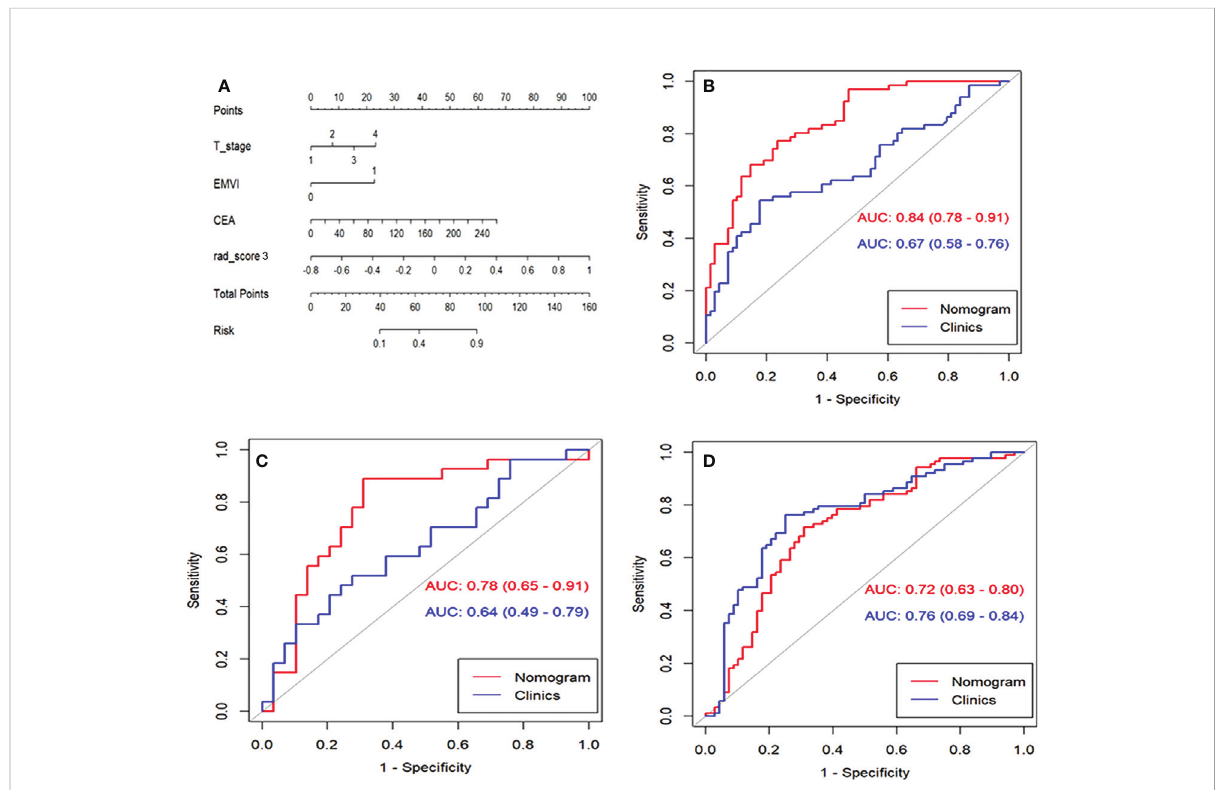
FIGURE 4 The performance and validation of the fi nal selected model to predict lymph node metastasis (LNM). (A) , The predictive nomogram of LNM in training cohort. (B) , Receiver operating characteristic curves (ROC) of clinical model and nomogram to predict LNM with rectal cancer in training cohort. (C) , ROC of clinical model and nomogram to predict LNM with rectal cancer in internal validation cohort. (D) ROC of clinical model and nomogram to predict LNM with rectal cancer in external validation